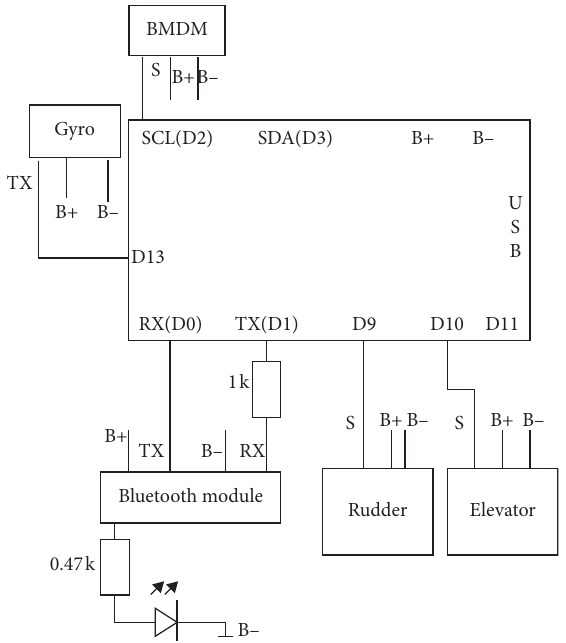
Figure 11: Hardware circuit connection